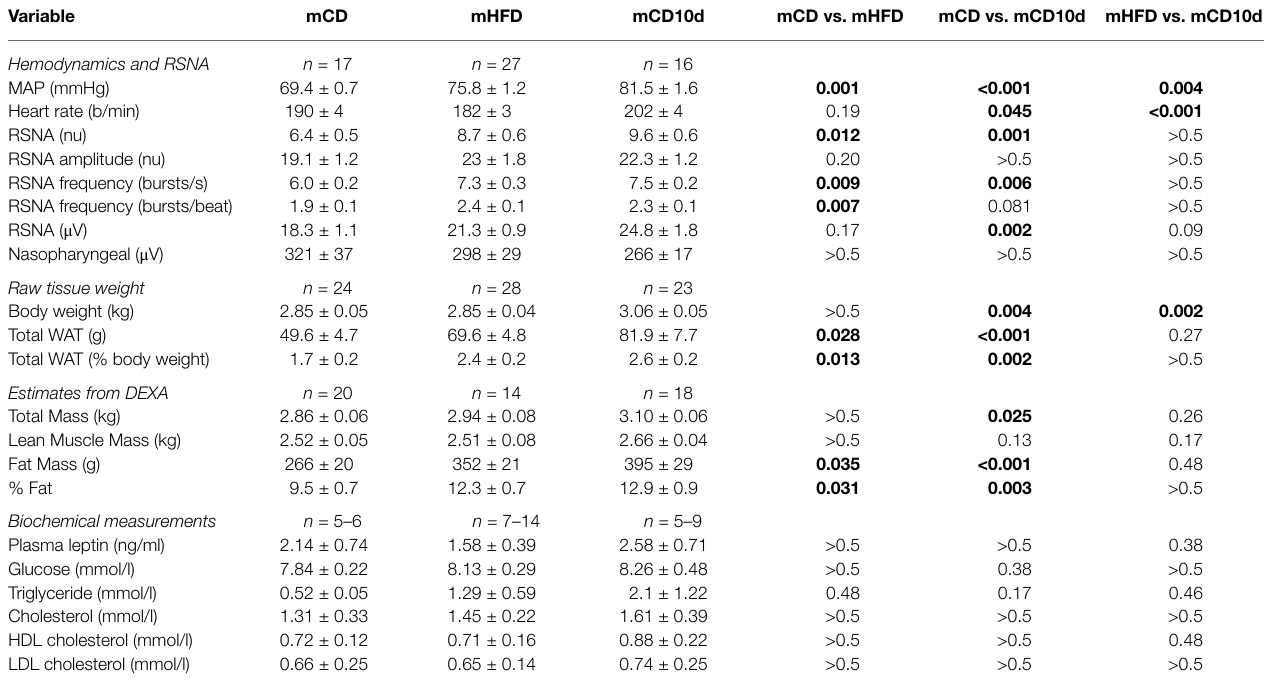
TABLE 2 | Hemodynamics and renal sympathetic nerve activity (RSNA), body composition, and biochemical measurements. Variable mCD Hemodynamics and RSNA